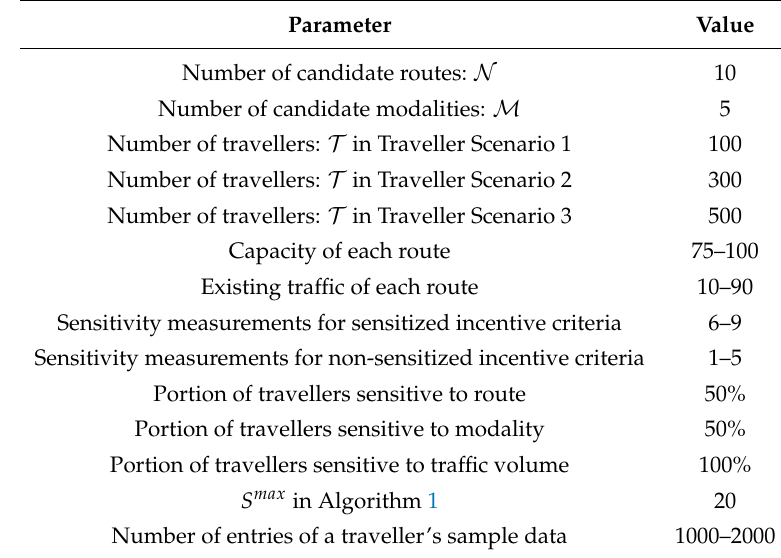
Table 5. Performance comparisons of different personal incentive